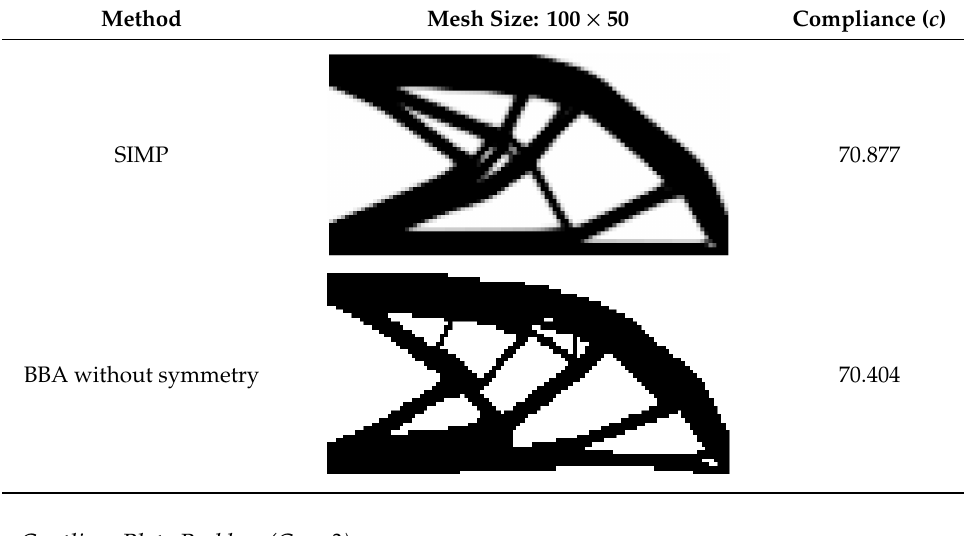
Table 3. Comparison of the best topologies of the cantilever plate (case 3).